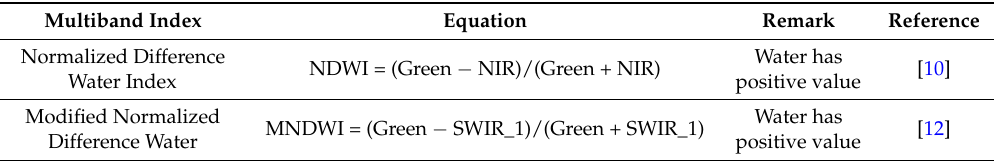
Table 3. Multiband indexes used for water feature